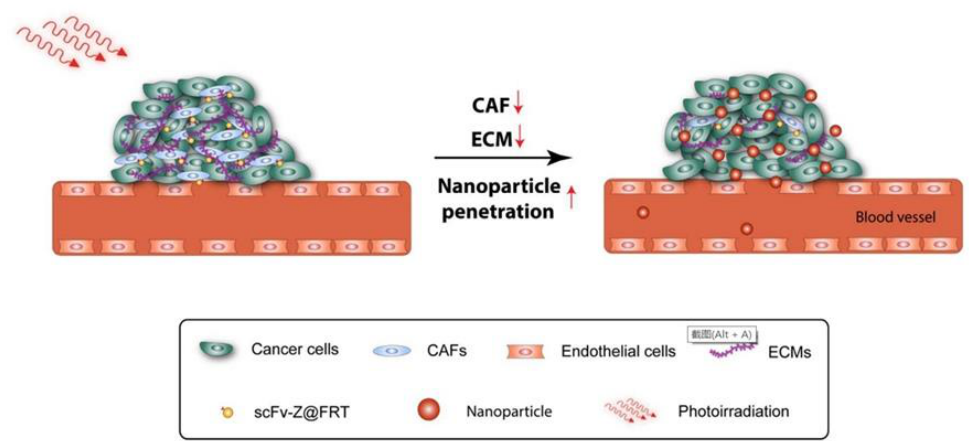
Figure 9. PDT affects the accumulation of ferritin nanoparticles in tumor sites. Reproduced with permission from ref [68].